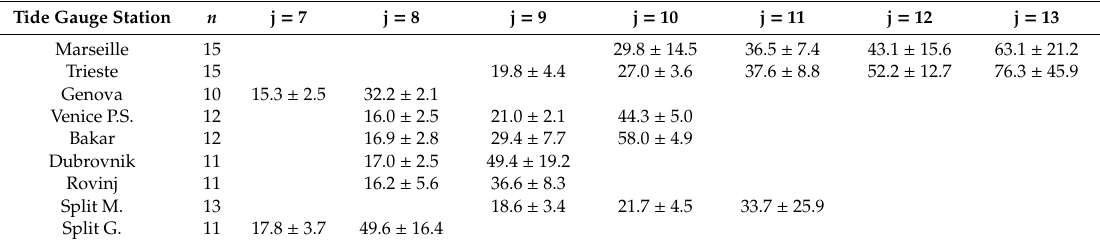
Table 1. Characteristic periods (years) of the significant intrinsic mode functions (IMFs) with a characteristic timescale > 15 years, obtained by the Empirical Mode Decomposition (EMD) for the analyzed data set. Errors are estimated as the standard